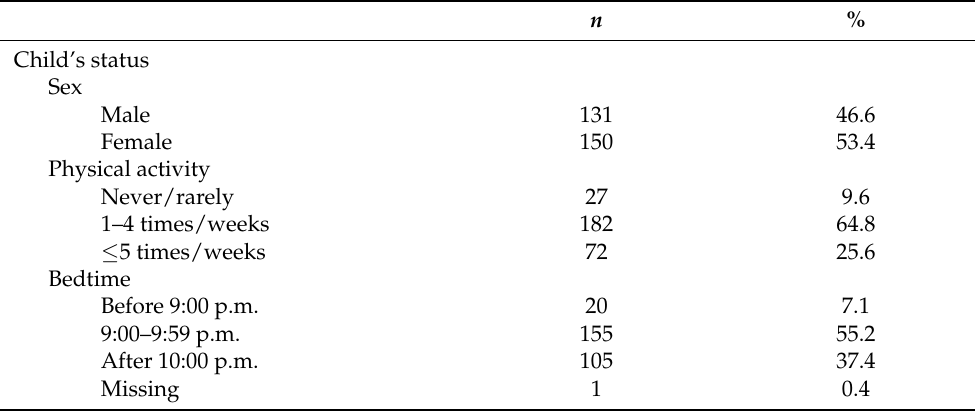
Table 1. Characteristics of the Japanese school children ( n =